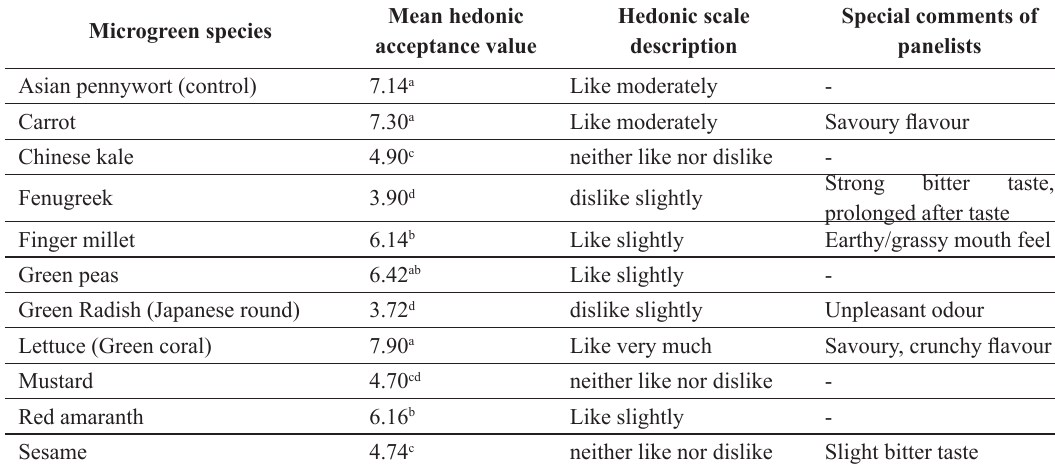
Different letters indicate a significant difference (p< 0.05) in different species compared to the control.